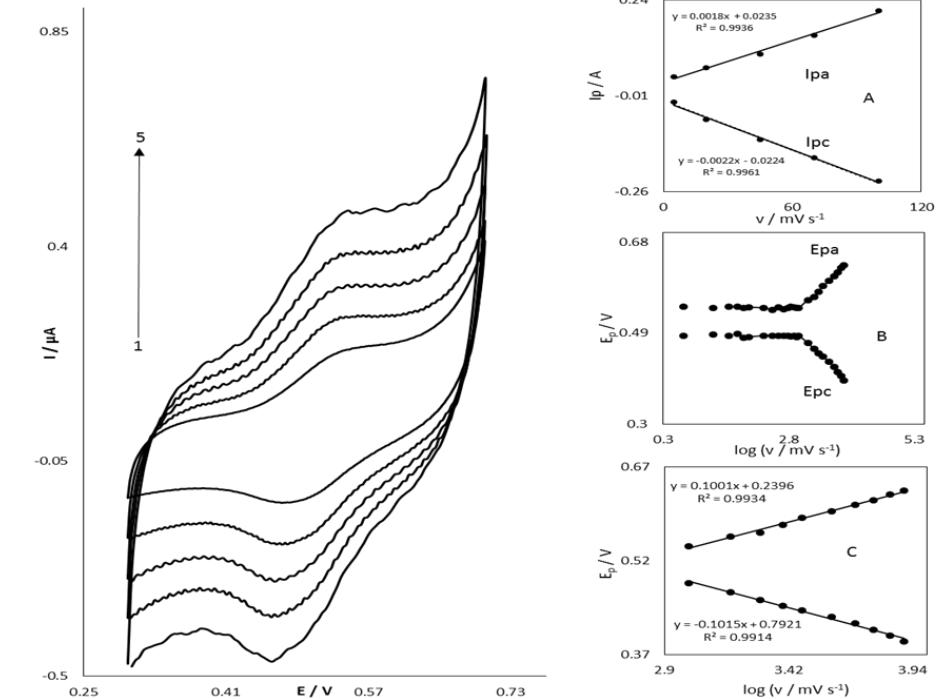
Figure 2. Cyclic voltammetric responses of GO/OB/SNP/SPE in 0.1 M phosphate buffer pH = 7.0 at different scan rates (The numbers 1–5 correspond to 20–100 mV s −1 ). Insets: ( A ) plots of anodic and cathodic peak currents vs. of scan rate. ( B ) Variation of the peak potentials vs. the logarithm of the scan rate. ( C ) Magnification of the same plot for high scan rates.